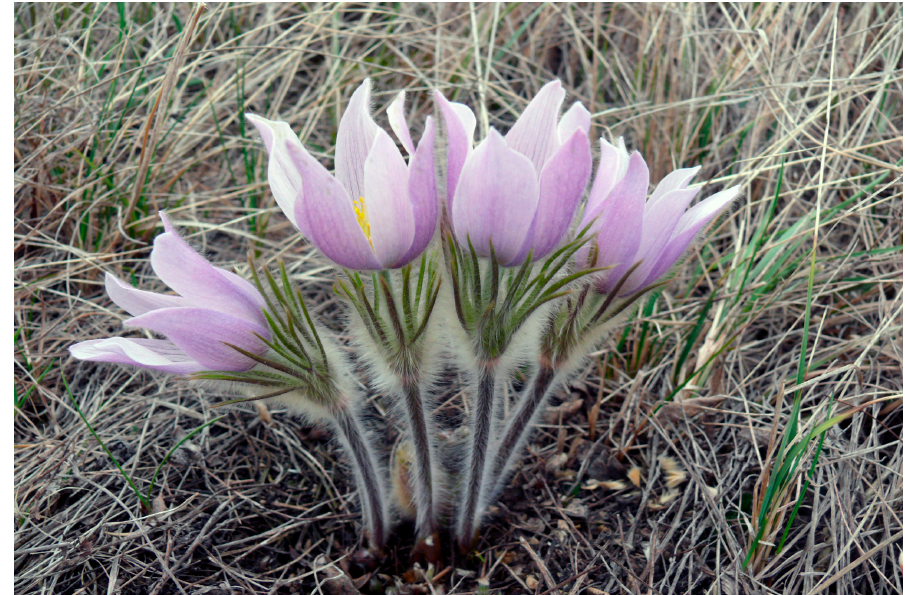
Figure 1. Anemone patens in the Northeast Swale area (Saskatoon, Saskatchewan). Photo by Vladimir Kricsfalusy.